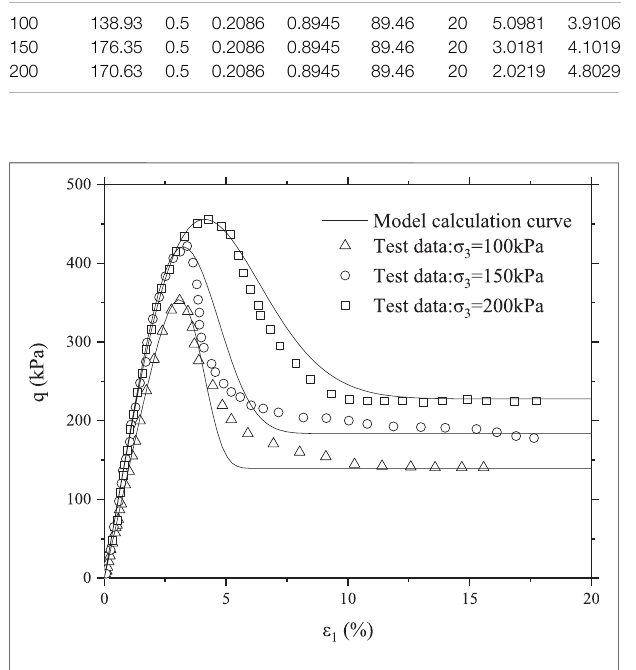
FIGURE 7 | Comparison between model calculation and test results in this paper.